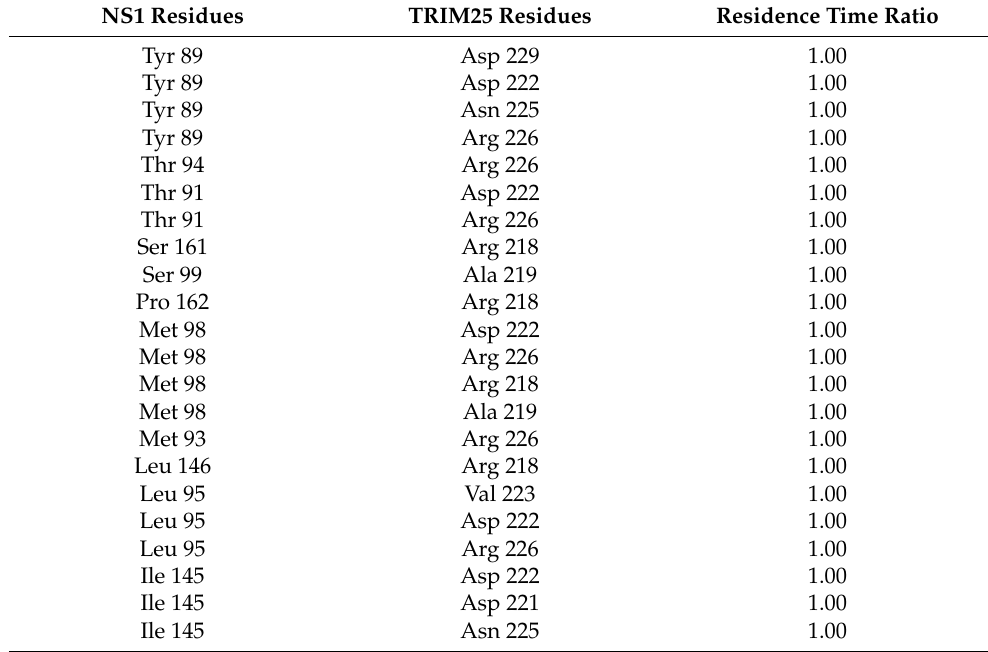
Table 4. Stable pairwise residue–residue interactions at the interface of the complex between NS1 and TRIM25 chain